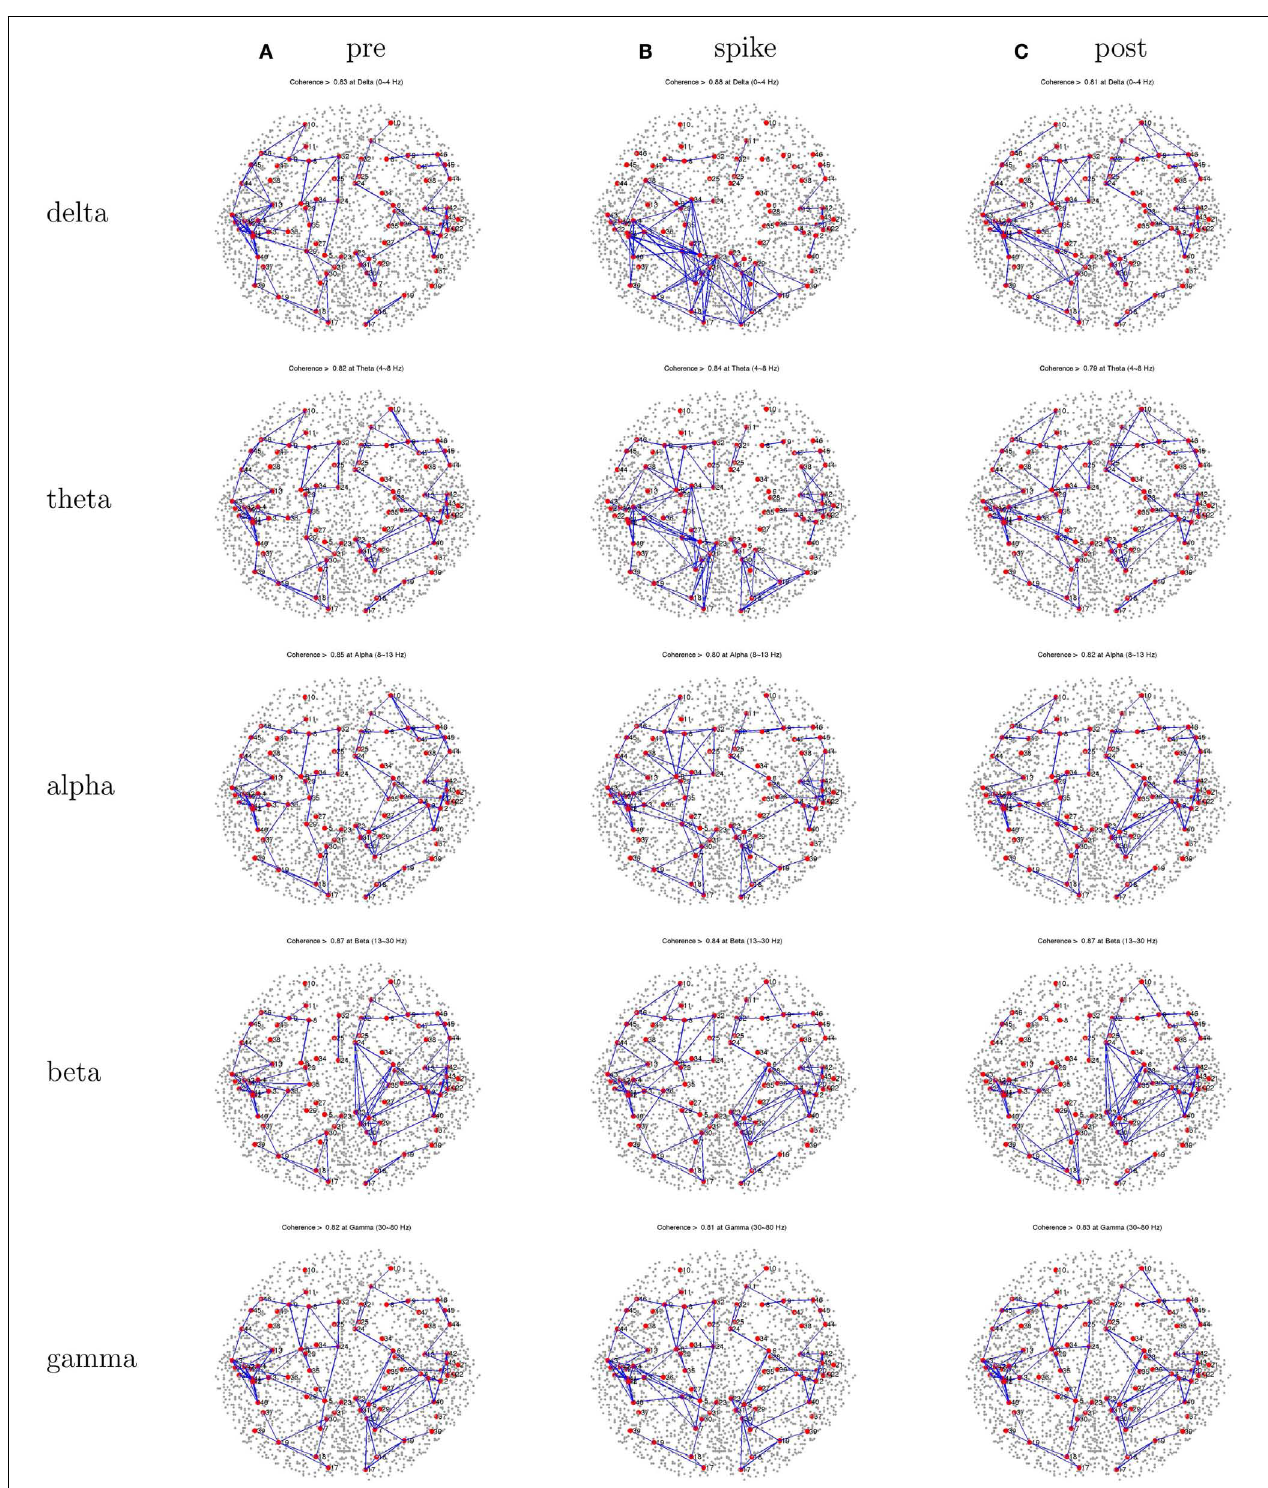
FIGURE 10 | Patient 4’s dEEG cortical source coherence peaks (highest 100 of ∼ 6400) for pre-spike (A), spike (B), and post-spike (C) intervals of the five frequency bands .